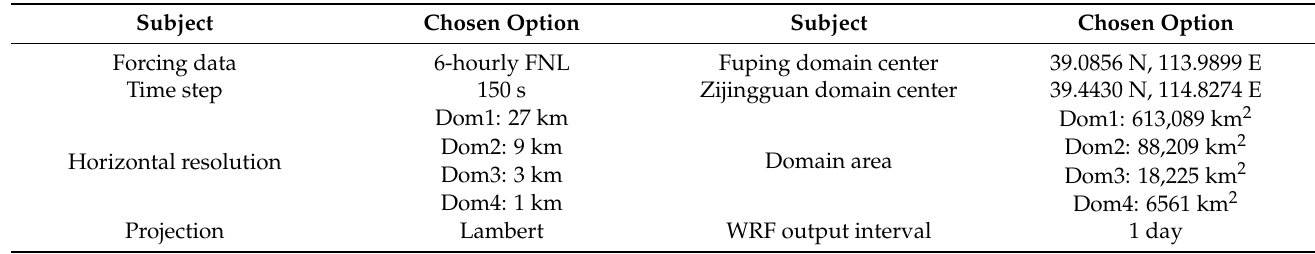
Table 1. Configurations of the WRF